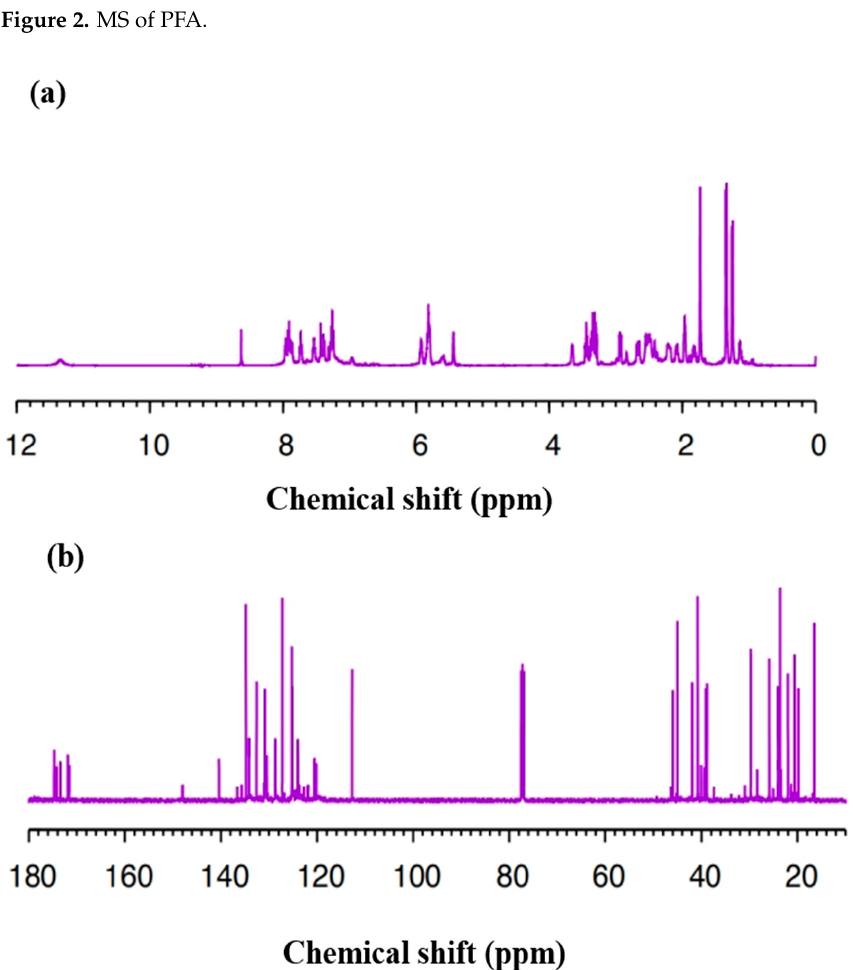
Figure 3. 1 H NMR ( a ) and 13 C NMR ( b ) spectra of LPFA.